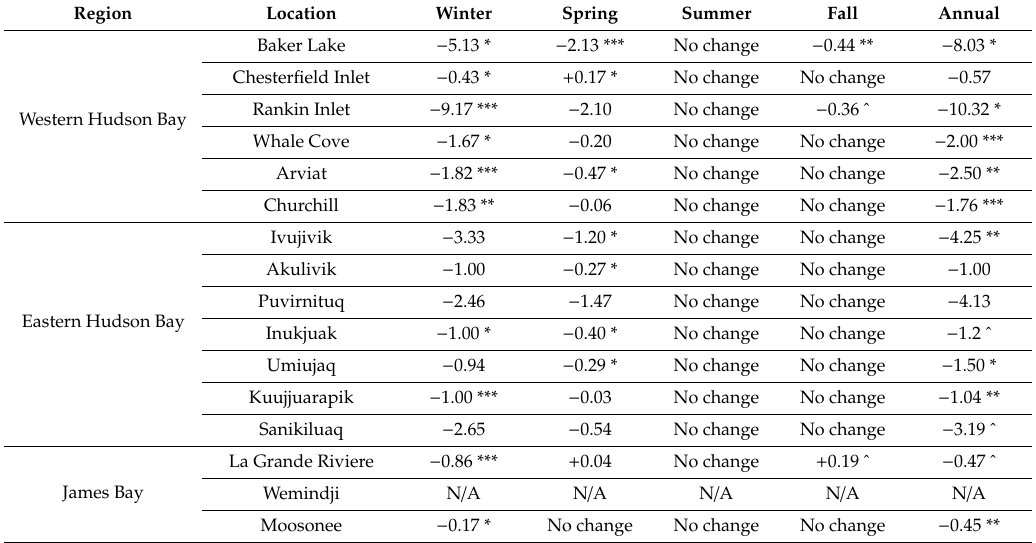
Table 4. Trends in ice fog hours per year with significance level adjusted for autocorrelation. Significance level: *** p < 0.001; ** p = < 0.01; * p < 0.05; ˆ p < 0.10. N / A = not applicable due to small sample size across the